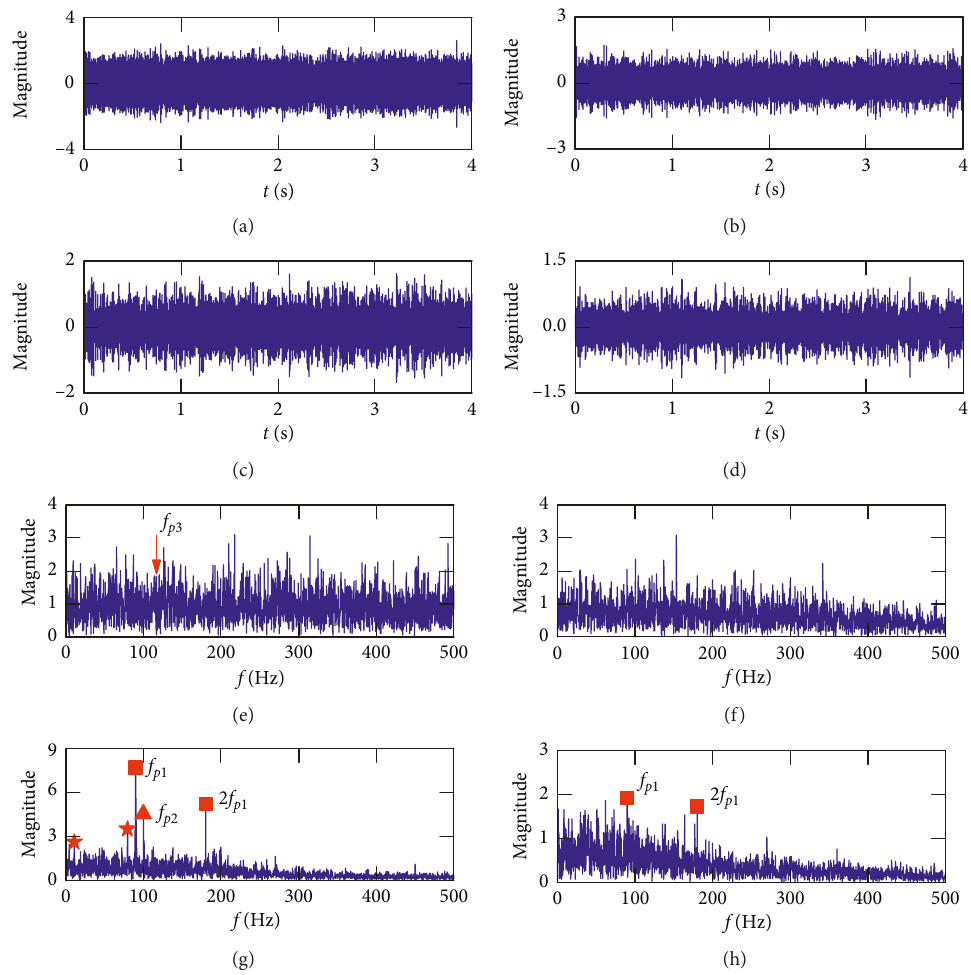
Figure 1: Waveforms (a–d) and envelope spectra (e–h) of the first four IMFs ( ε